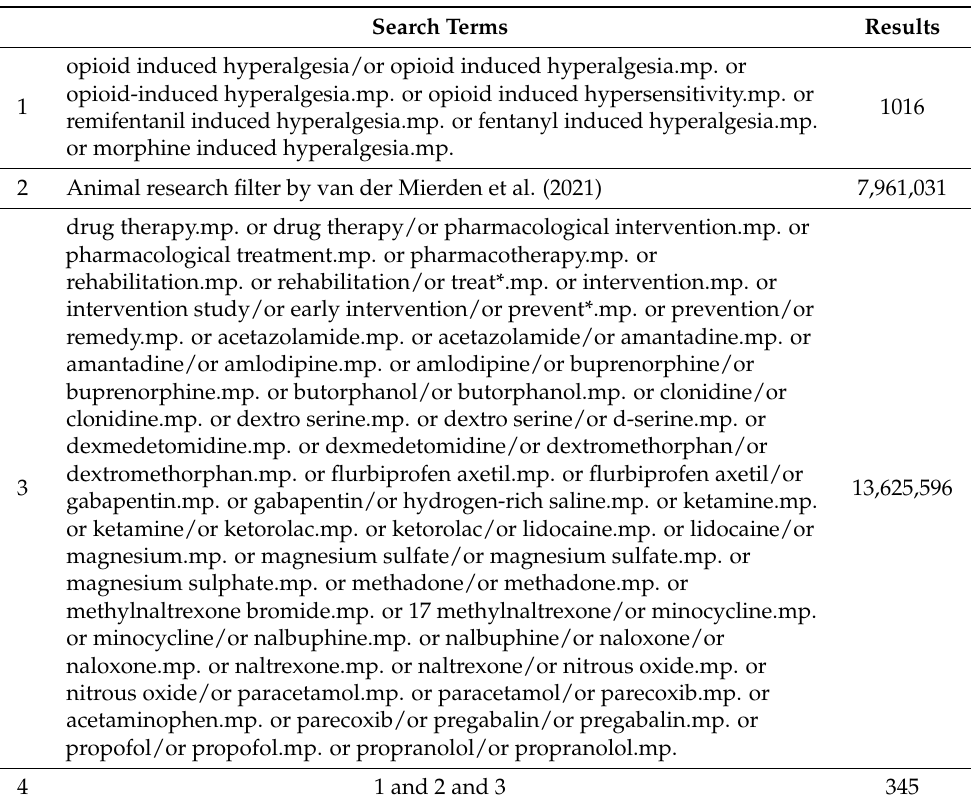
Table A3. Final Embase search (via Ovid). The number of records retrieved for the disease of interest (1), animal research (2), interventions (3), and their combinations (4).